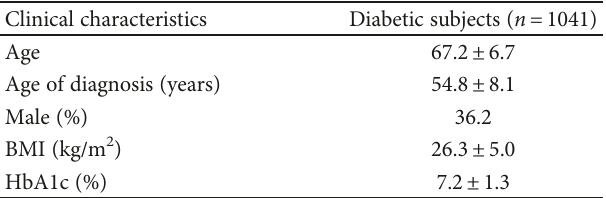
Table 2: The biochemical and clinical characteristics of two patients with T2DM carrying the mt3243 A > G